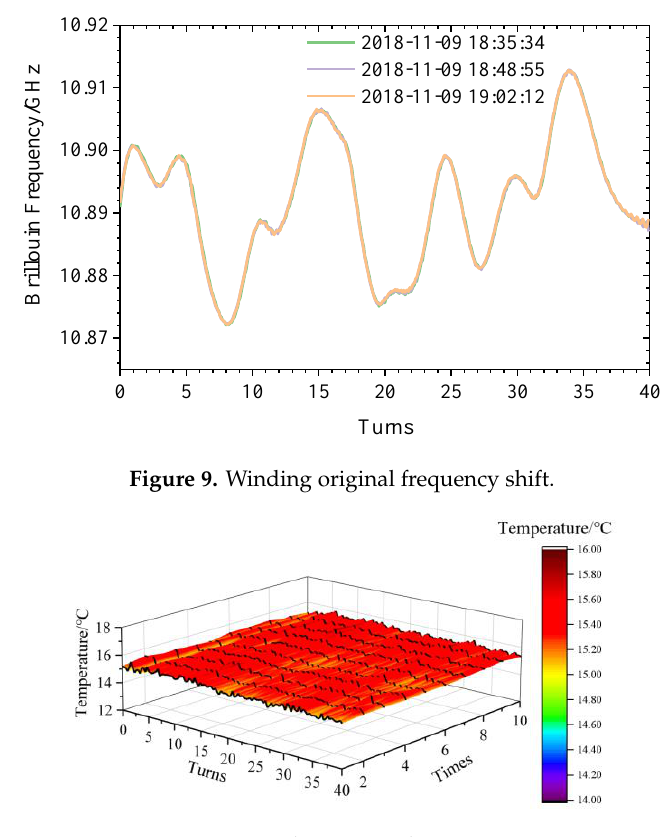
Figure12. BOTDR detection curve